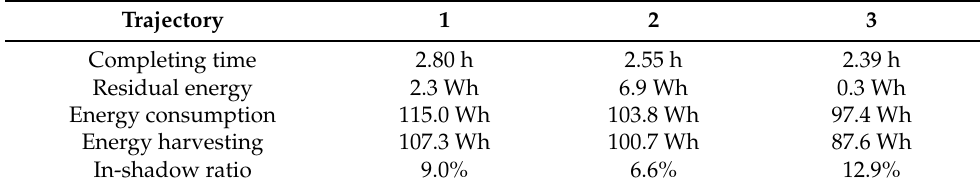
Figure 11. Results about energy. ( a ) Energy consumption power. ( b ) Energy harvesting power (When the harvesting power is zero, it means that the UAV is located in the shadow created by the mountains). ( c ) Residual energy in the battery. Table 3. Comparison of the three